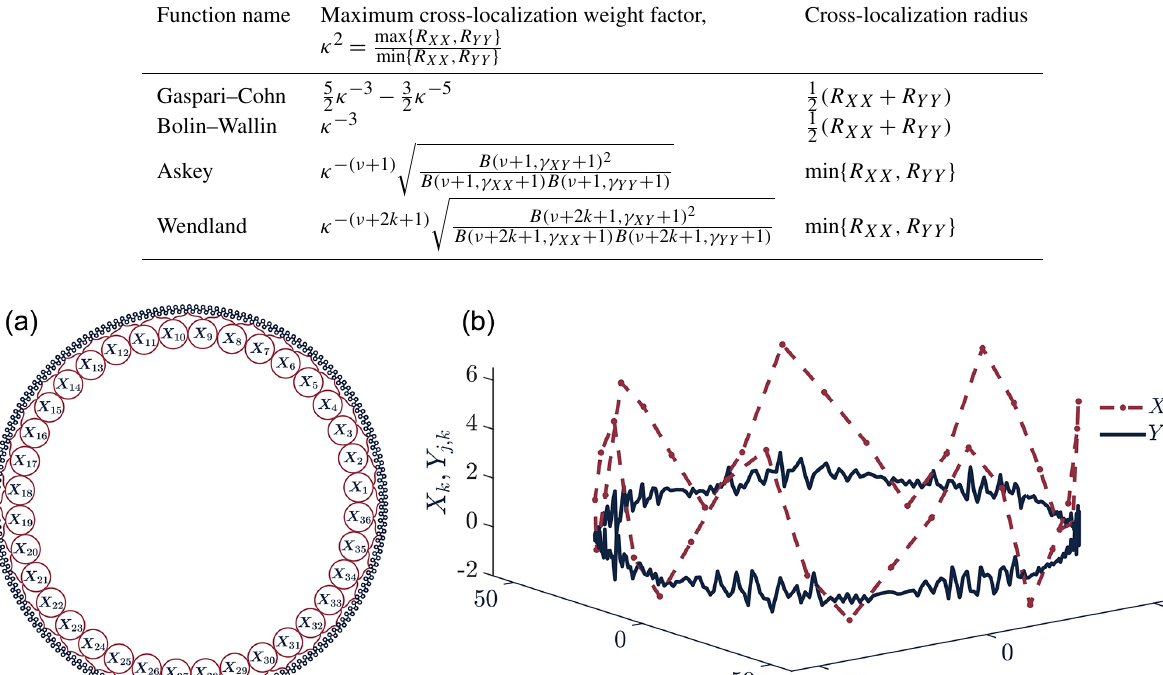
Table 2. Summary of important shape parameters for four cross-localization functions.